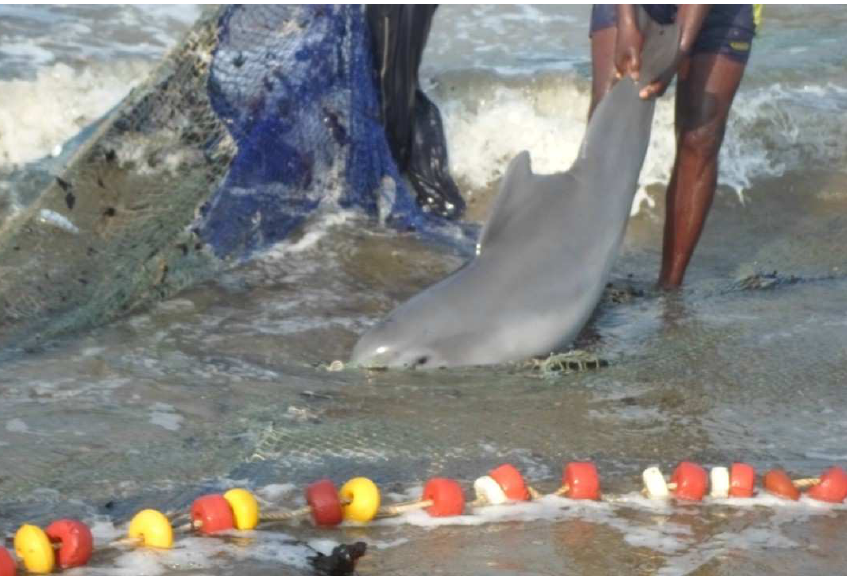
Figure 3. In December 2021, MPA rangers collaborated with fishers in an admirable effort to free four Atlantic humpback dolphins caught accidentally in beach-seine nets near Cap Lopez, Gabon. Such rescue attempts can be difficult and dangerous for both the people and the animals. Circumstances may dictate what can be done to free a dolphin from fishing gear and return it to the water safely. Ideally, the animal should be supported under its body and not pulled by the tailstock. Guidelines for safe handling and release are available from the CMS [58]. Photo courtesy of Igor Akendengue.